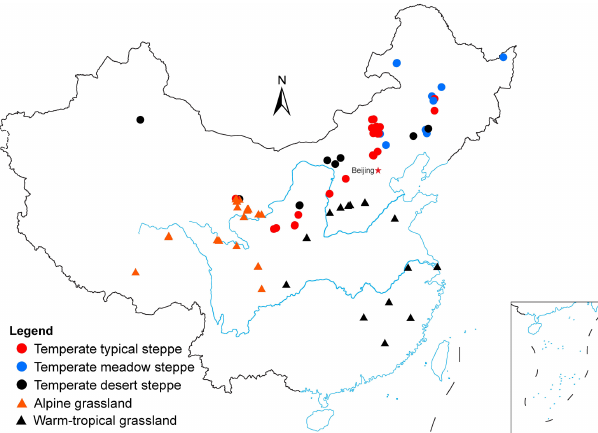
Figure 1. The site location of soil respiration studies selected in this study across Chinese grasslands. Publisher’s remark: Please note that the above figure contains disputed